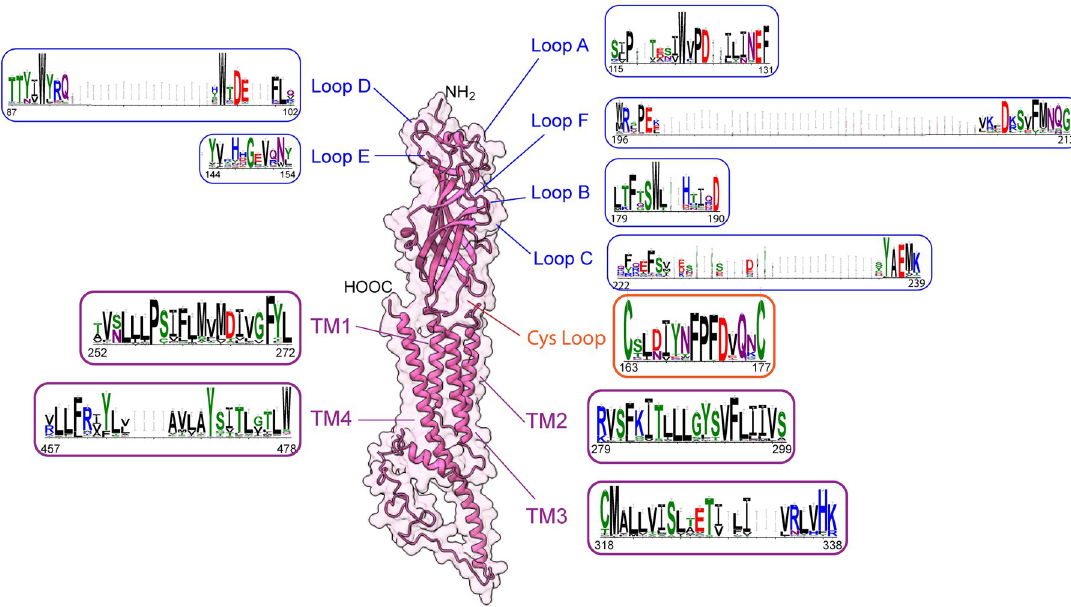
Fig 5. Consensus amino acid logos of 5HT3A subunit regions derived from 449 different animal species. Human 5HT3A subunit tertiary structure is modelled using information from PDB 6np0.1 using Swiss modelling [94] software and edited in UCSF Chimera software [116]. Sequence logos of loops A to F, TM domains and Cys-loop represented according to Table 2 and Figs 4 and S6 and